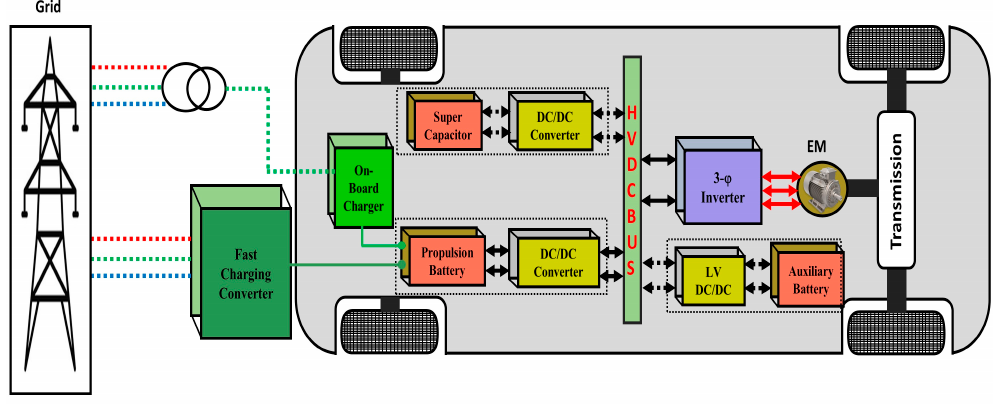
Figure 1. Schematic diagram of an EV powertrain with fast-charging stations [6].